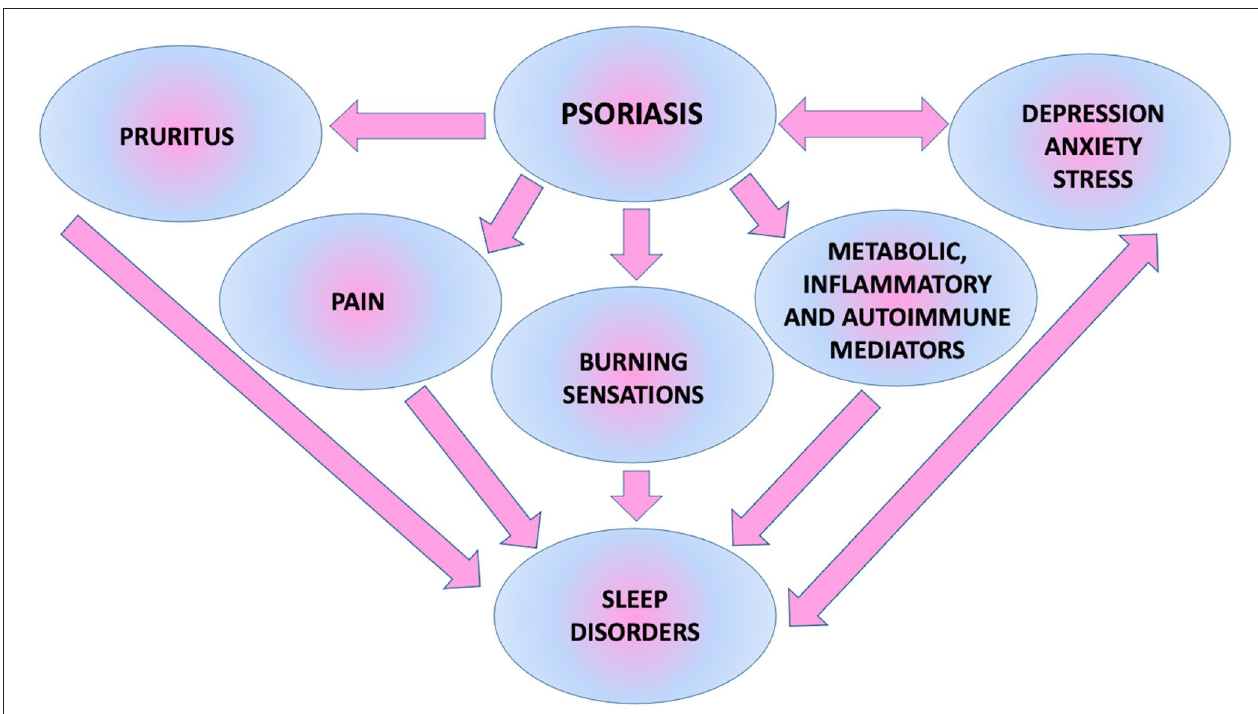
FIGURE 4 | Factors associated with psoriasis which might negatively affect sleep